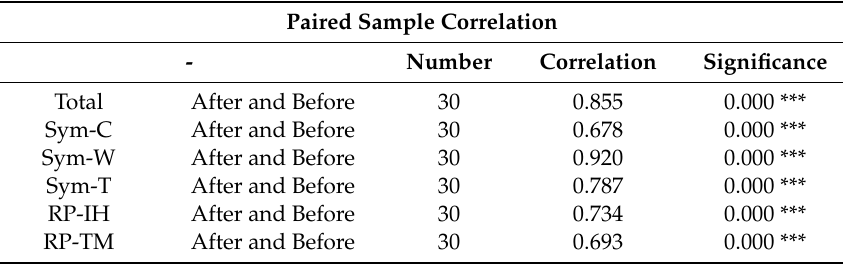
Table 10. Pre- and post-test on situations related to Internet addiction. Paired Sample Correlation